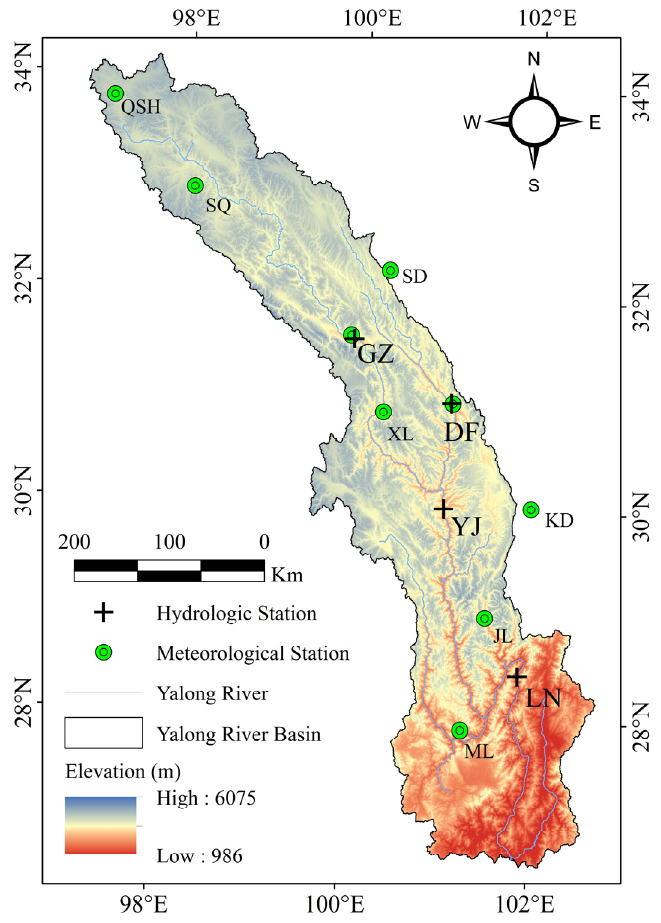
Figure 1. Distribution of the water system and stations in the YLB.